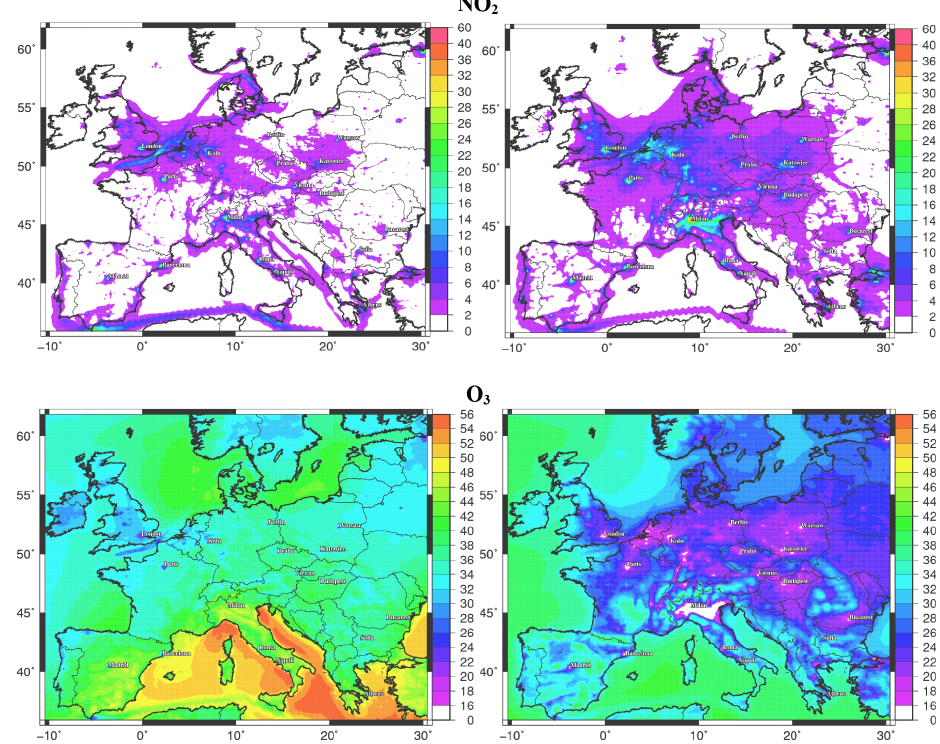
Figure 7. Modelled NO 2 and O 3 (ppb) concentrations fields calculated for the summer (left) and the winter (right)